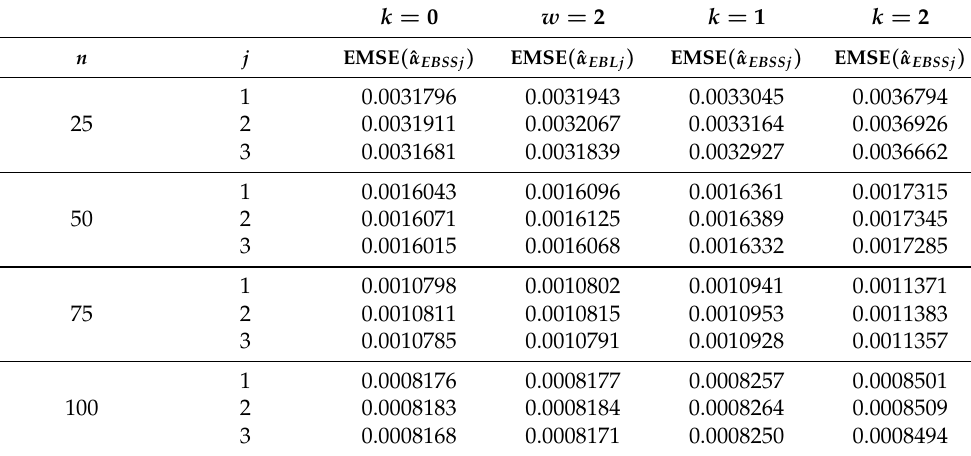
Table A1. Simulated EMSE of ˆ α with s = 0.9, β = 1.5, u = 4 and v = 5.